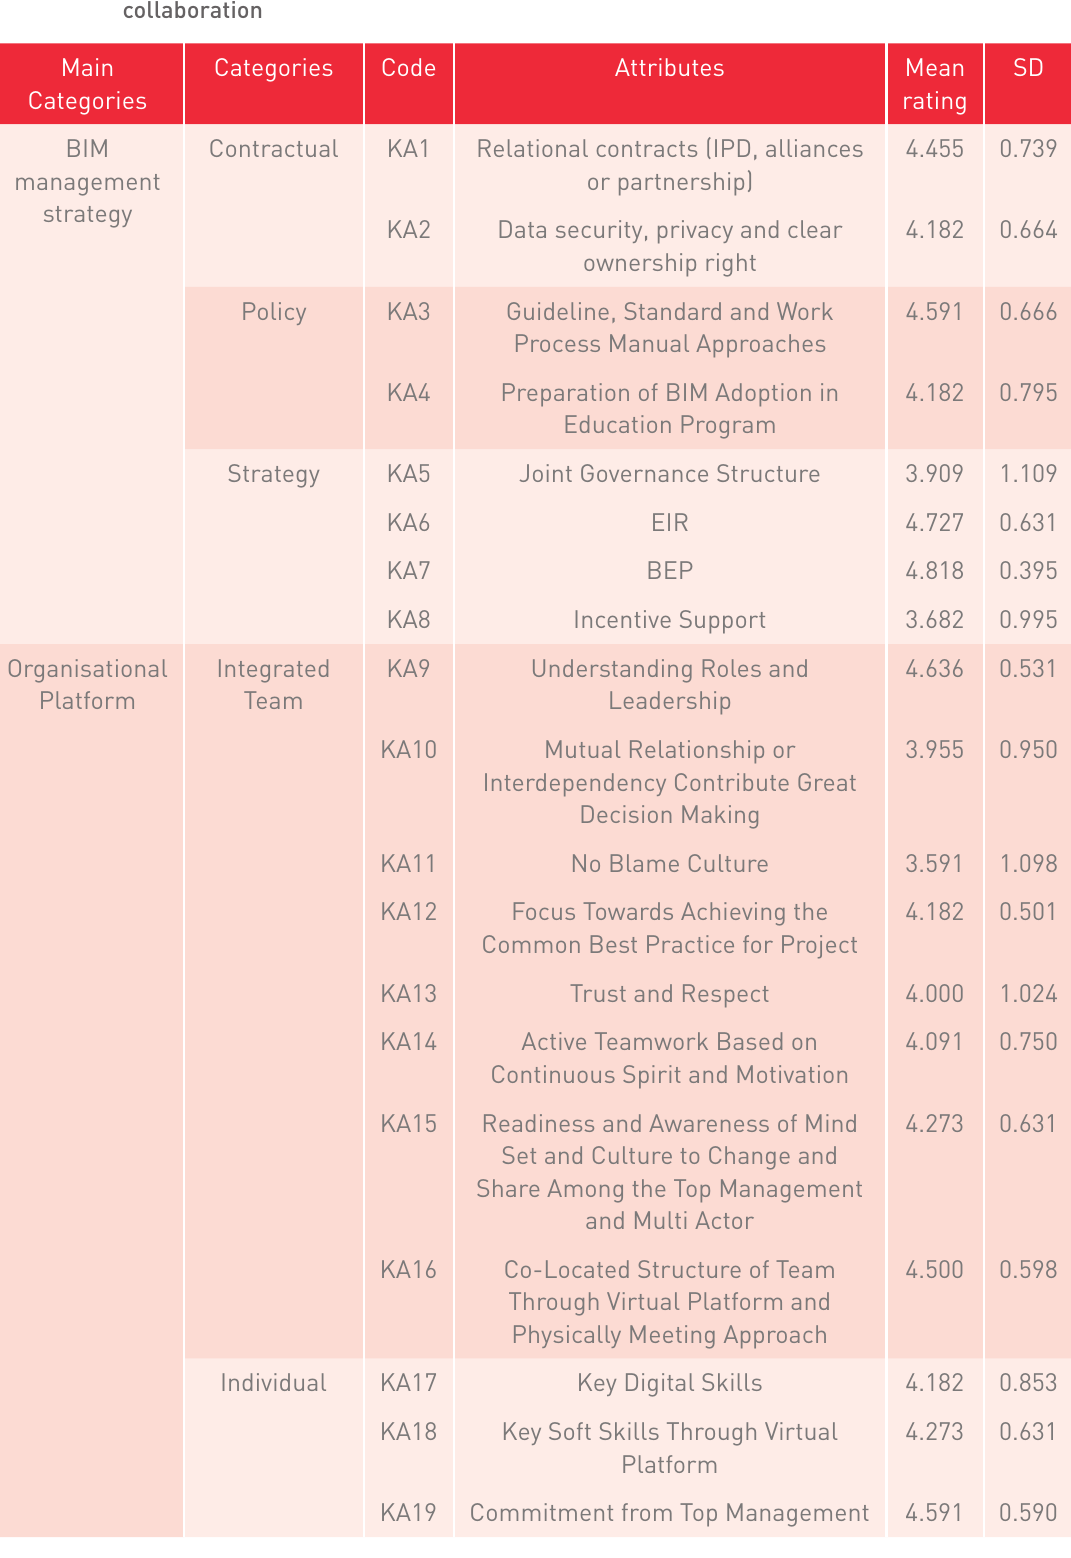
Table 2. Mean rating and standard deviation of KAs influencing the multi-actor social